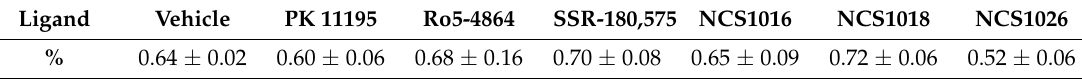
Table 2. Hemolysis induced by TSPO ligands